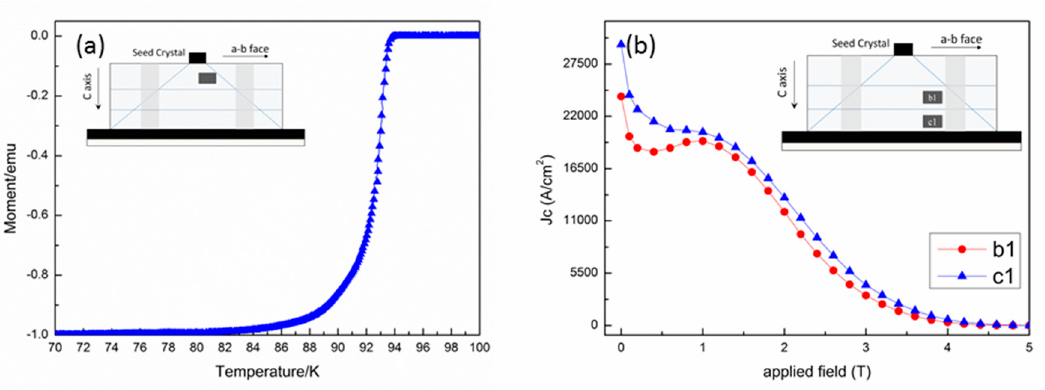
Figure 5. The superconducting properties of specimens cut from different positions in a drilled single domain SmBCO bulk superconductor: ( a ) critical temperature; ( b ) critical current density.